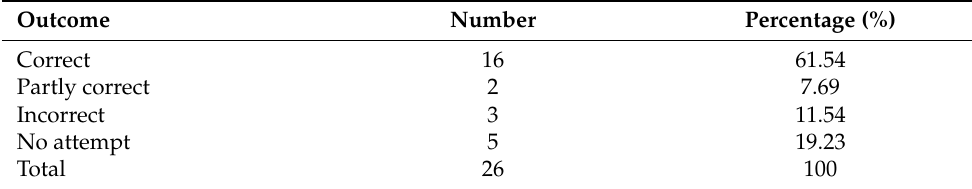
Table 1. Overall performances of students in solving the first word